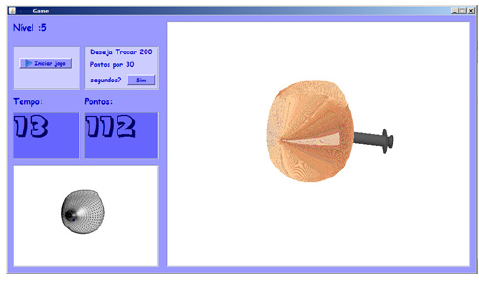
Figure 2. Example of a serious game for student evaluation